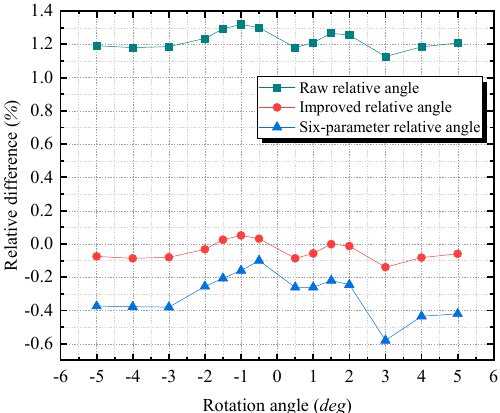
Figure 12. The relative di ff erences of the measured angles (the raw relative angle, the improved relative angle, and the six-parameter relative angle) from the reference relative angle. The relative di ff erence is equal to (value measured by di ff erent methods – reference relative angle) / reference relative angle.